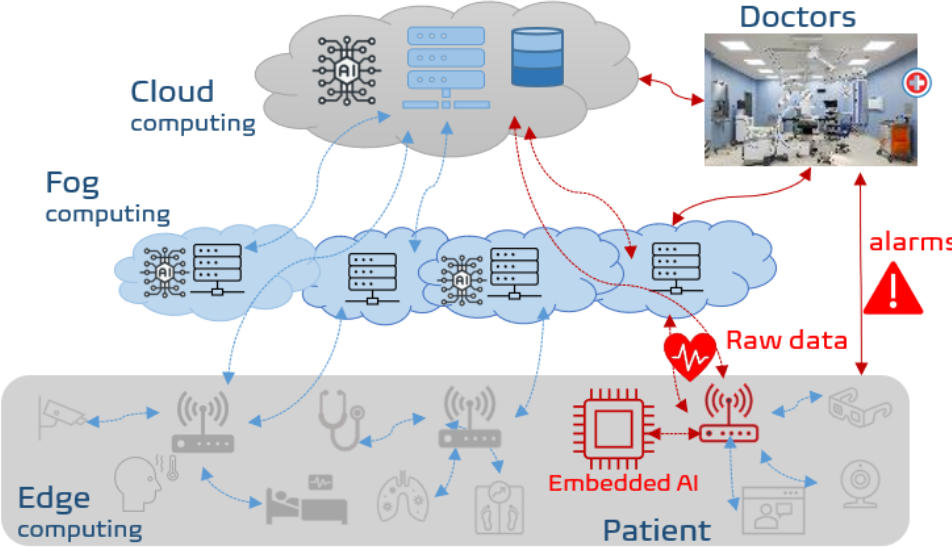
Figure 1. Overall framework of remote health monitoring in rural areas. In red is the flow related to ECG data. The classification is done by embedding intelligence near sensors and sending only alarms. If necessary, raw data can be sent to fog or cloud for further analysis or storage.